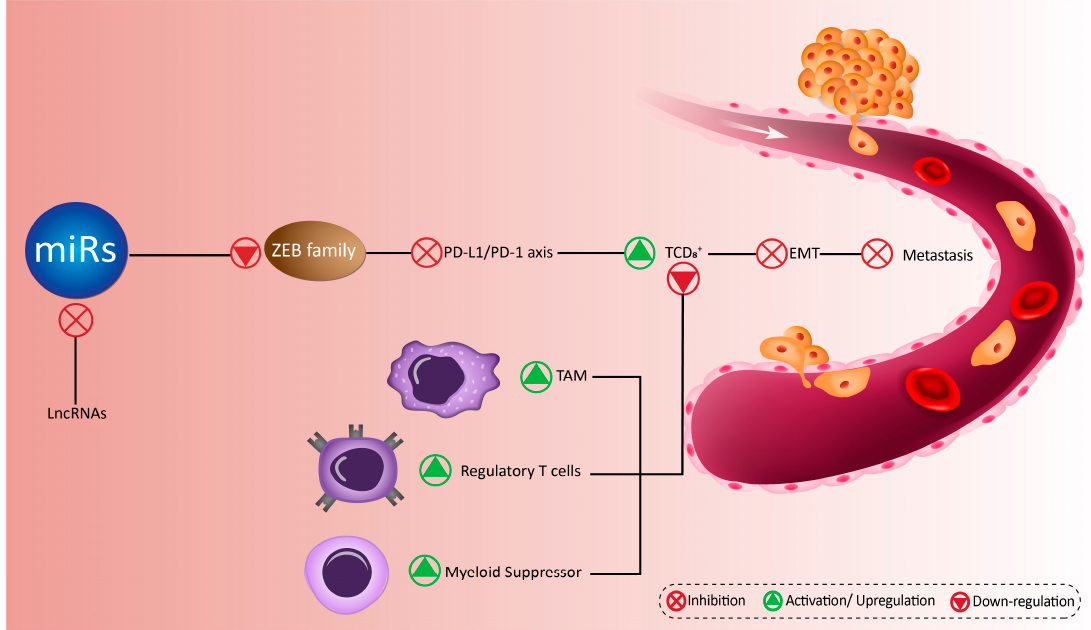
Figure 4. How tumor microenvironment components are affected by the relationship between miRs and ZEB proteins, and their regulation by lncRNAs.